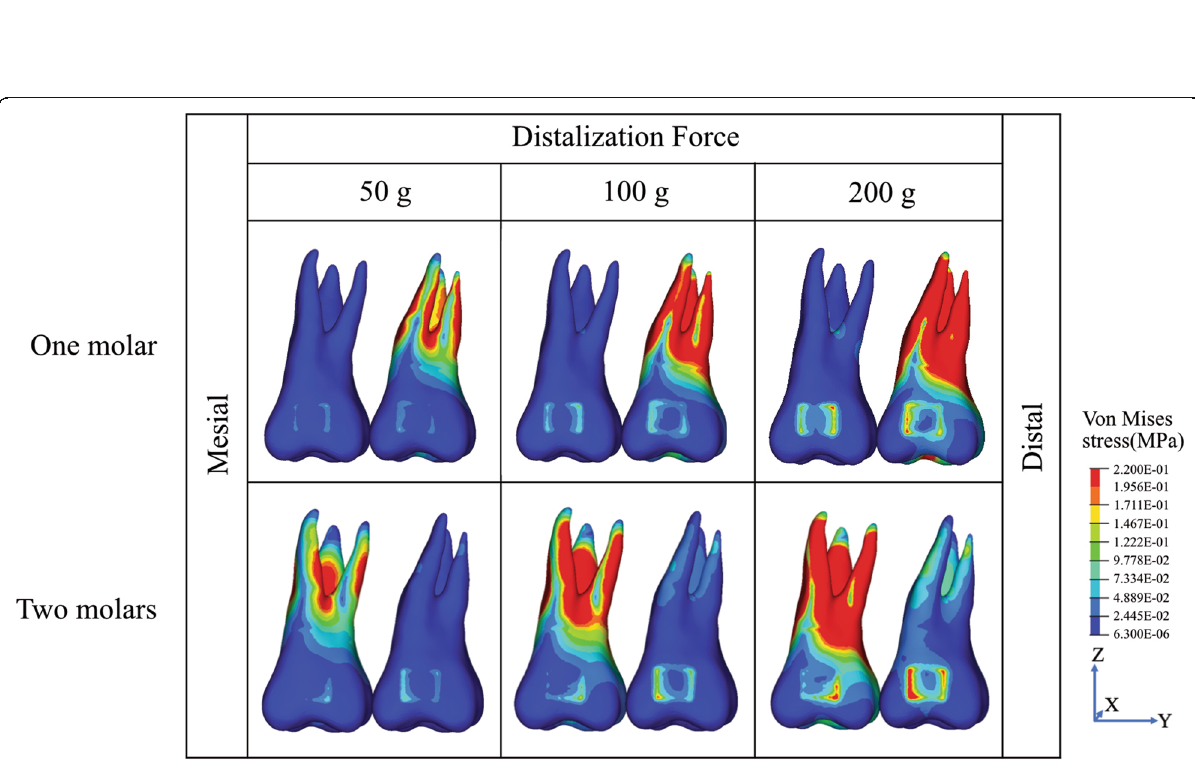
Fig. 3 The von Mises stress distribution of one molar distalization and two molars